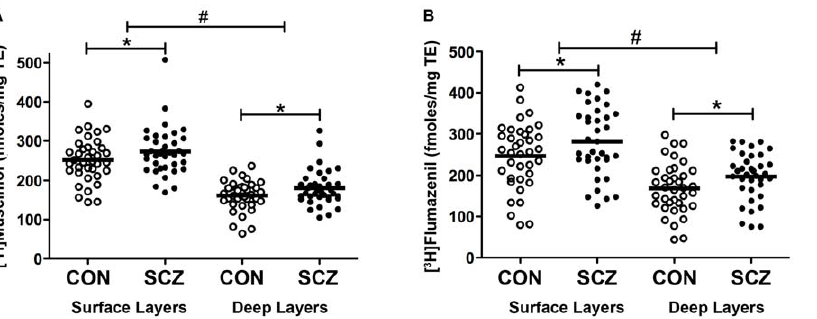
Figure 2. Scatter plots presenting the binding values (fmoles/mg tissue equivalent) of [ 3 H]Muscimol (A) and [ 3 H]Flumazenil (B) in control (CON) (n=37) and schizophrenia (SCZ) (n=37), in the superficial (surface) and deep layers of the DLPFC. *=p , 0.05 and refers to a significant main effect of diagnosis (schizophrenia . control); # =p , 0.001 and refers to a significant main effect of layers (superficial . deep) after two-way ANCOVA. Bars represent the